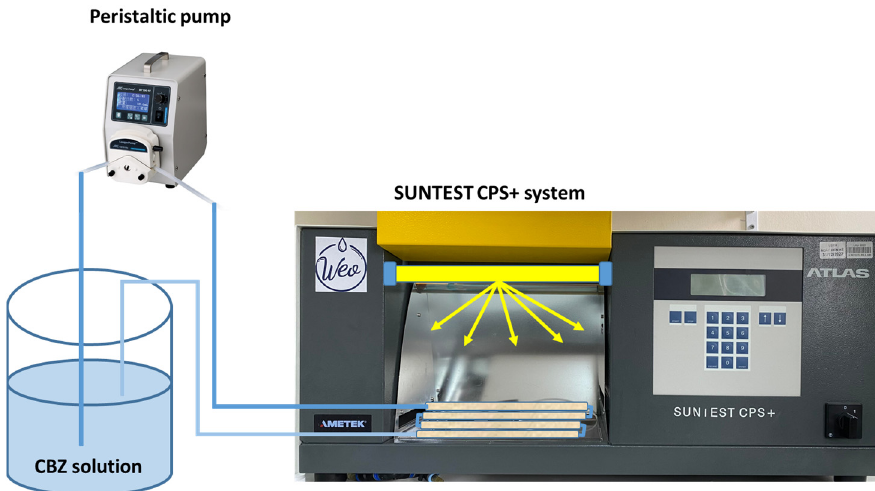
Figure 1. The degradation system of carbamazepine.